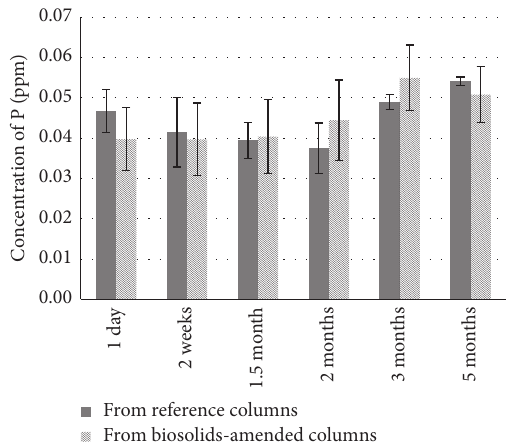
Figure 3: Concentrations of soluble reactive phosphorus in ana- lyzed leachate. The error bars represent standard deviation among replicate